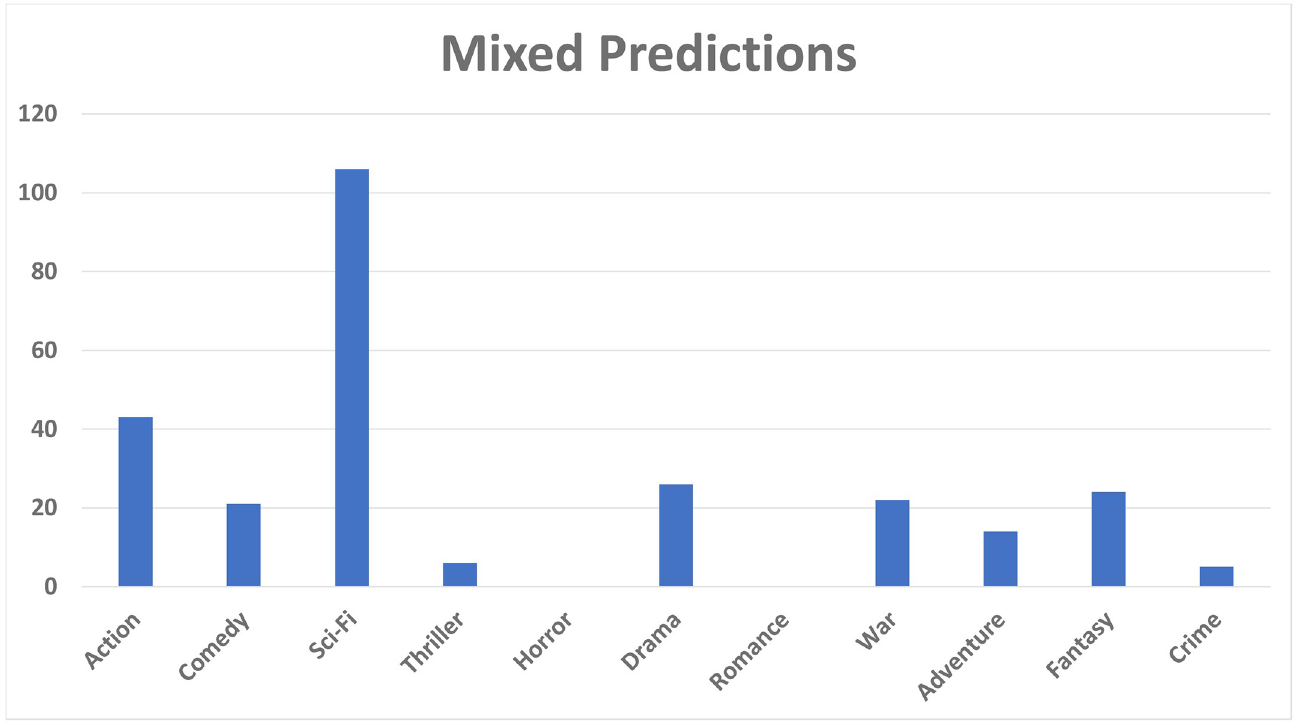
Fig 9. Mixed predictions by